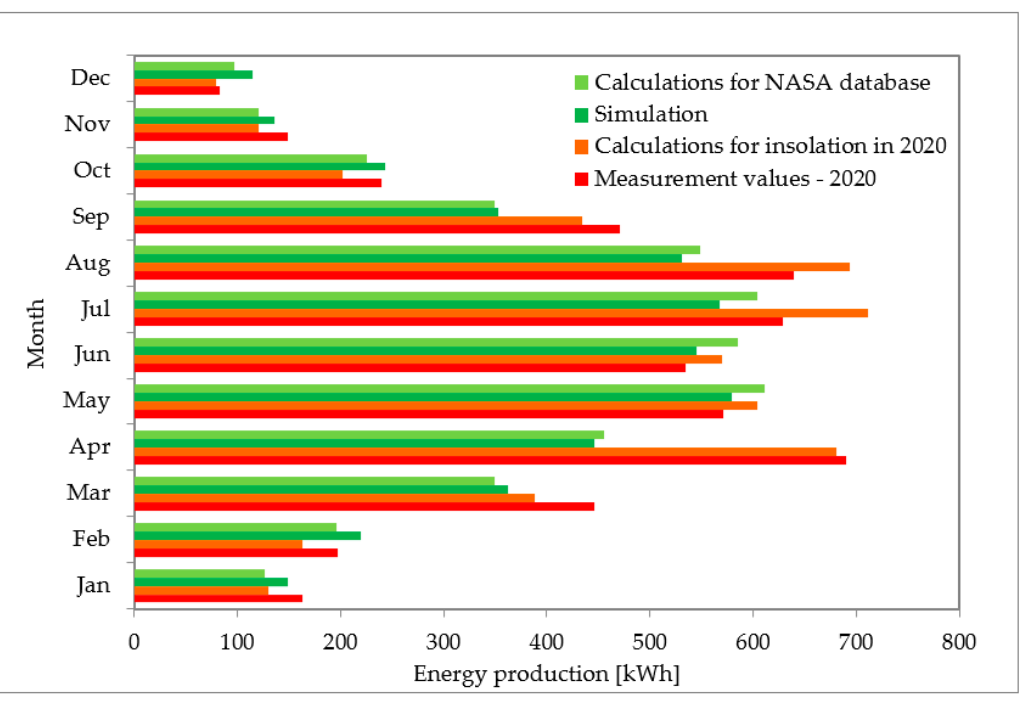
Figure 13. Monthly energy production over a year.